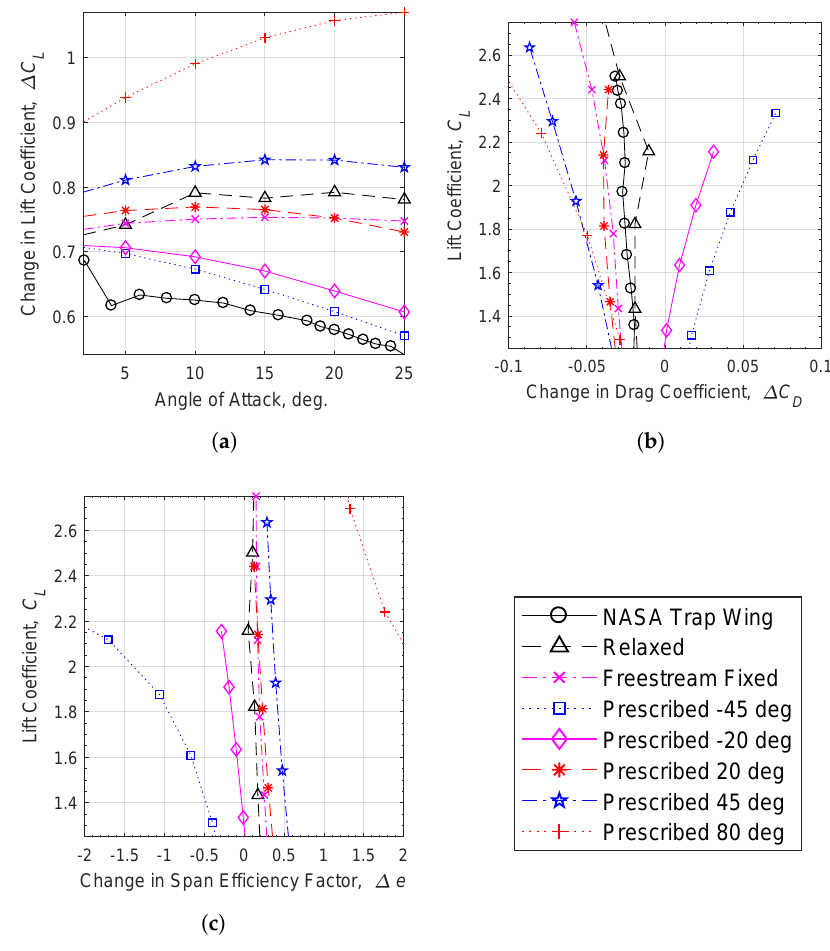
Figure 21. Predicted and experimentally-observed performance changes due to a change in flap span, from a part-span flap to full-span flap. ( a ) Lift predictions, ∆ C L = C L , Config 1 − C L , Config 9 ; ( b ) drag predictions, ∆ C D = C D , Config 1 − C D , Config 9 ; ( c ) span efficiency predictions, ∆ e = e Config 1 − e Config 9